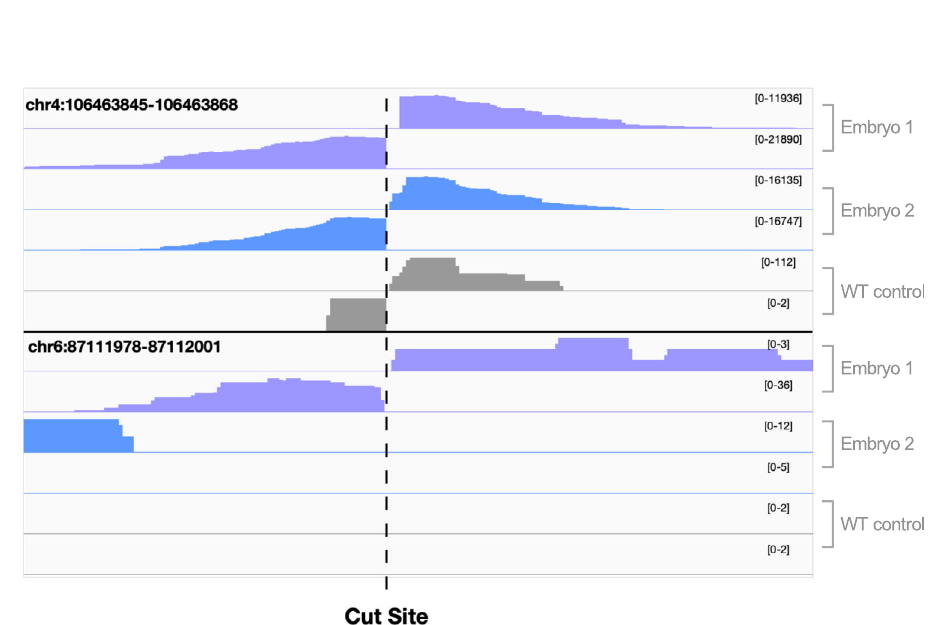
Fig. 4 | PEAC-seq identi fi ed pcsk9 off-targets from an edited mouse embryo. a Schematic representation of the in vivo PEAC-seq experiment. b The Venn dia- gram shows the overlap between the PEAC-seq on-target and off-targets of PCSK9 and the top18 editing sites (including the on-target) identi fi ed by DISCOVER-seq. c Thesequence visualization of the PCSK9 on-target and off-targets. One off-target was identi fi ed from one of the two embryos. The site was also reported by